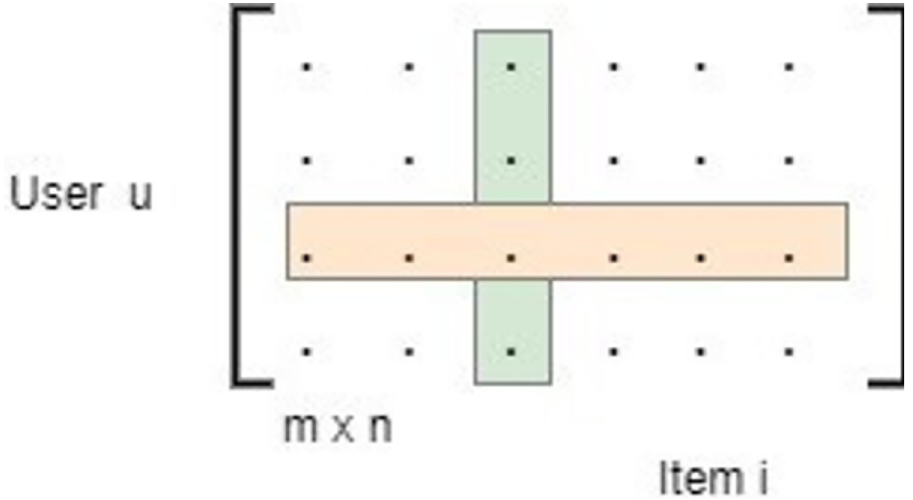
Fig 6. User-item affinity